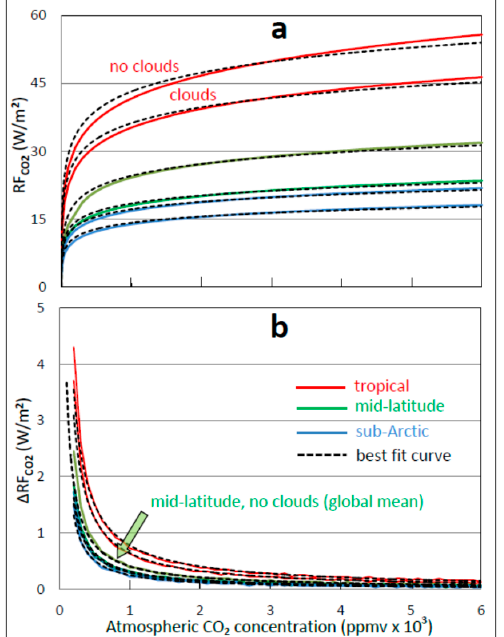
Figure 8. Relationship among atmospheric CO 2 concentration, radiative forcing (RF) and marginal radiative forcing ( Δ RF CO2 ) computed using MODTRAN. Each graph shows a family of curves for three latitudes (key in ( b )) and two cloud conditions (labeled only for the top pair of red curves in ( a )). For each latitude the upper curve pertains to a cloudless sky and the lower curve to a cloudy sky containing cumulus clouds starting a base at 0.66 km and a top of 2.7 km. Remaining model parameters used to generate curves are described in the text. ( a ) Atmospheric CO 2 concentration versus RF at the tropopause. ( b ) Difference analysis of the curves in ( a ) to show marginal radiative forcing ( Δ RF CO 2 ), i.e., the change in forcing associated with a unit increment in atmospheric CO 2 . Colored curves are in all cases computed from MODTRAN while the dashed black curves are best-fit logarithmic ( a ) or power function trendlines ( b ). Abbreviations: ppmv, parts per million by volume; W / m 2 , Watts per square meter. The arrow identifies the reference curve used for computing Δ RF CO 2 decay constants because it most closely approximates values for the International Standard Atmosphere (see text).